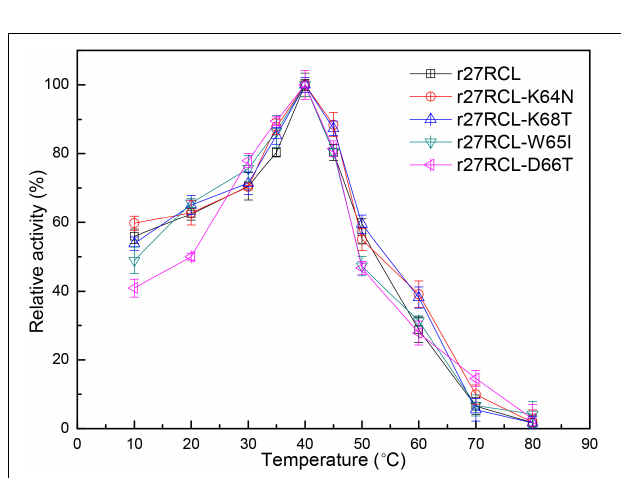
FIGURE 3 | The impact of temperature on recombinant Lipr27RCL, Lipr27RCL-K64N, Lipr27RCL-W65, Lipr27RCL-D66T, and Lipr27RCL-K68T.